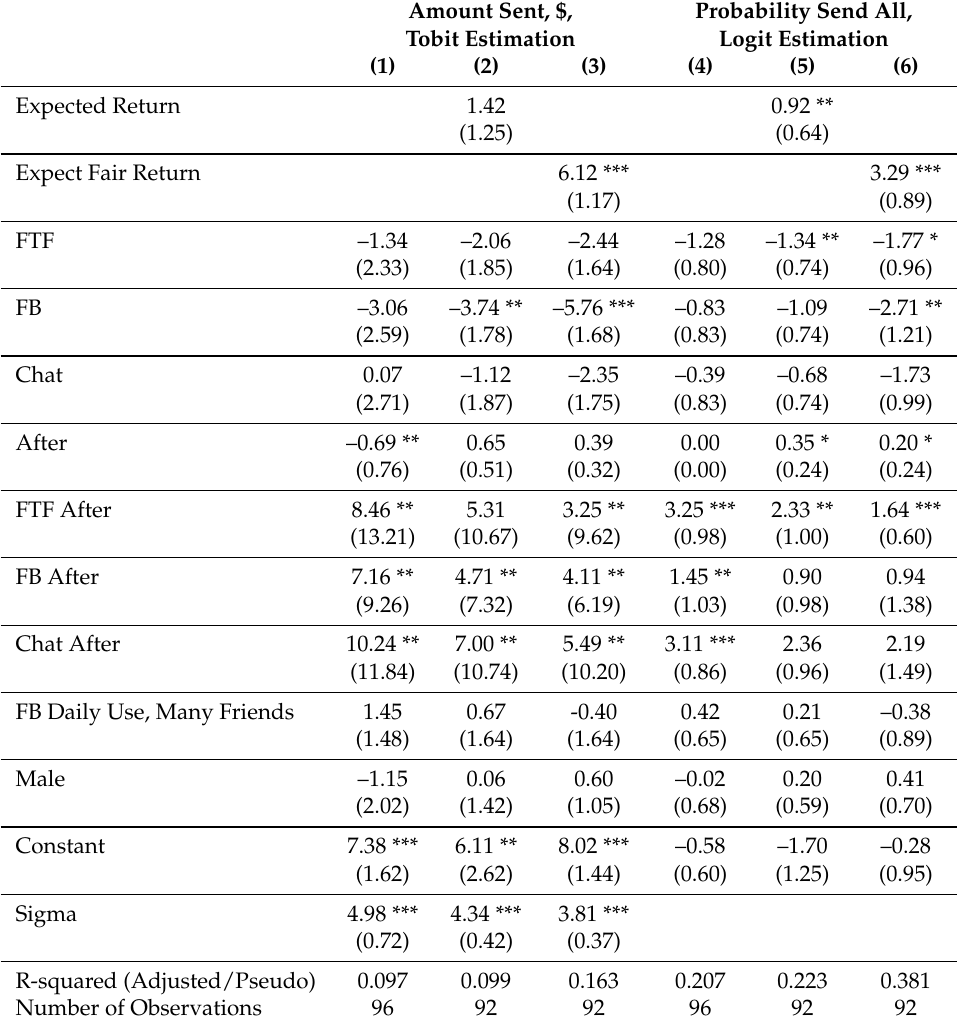
Table 3. Sender decision: regression